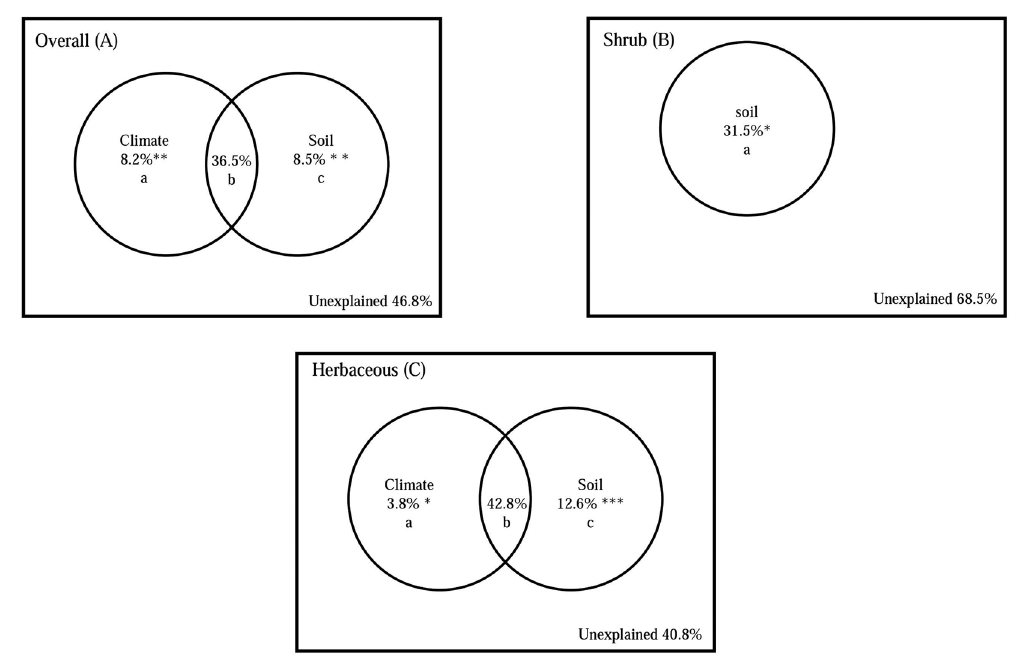
Figure 6. Variation partitioning for the effects of climate and soil attributes on overall ( A ), shrub ( B ), and herbaceous LPSR ( C ). The variation in LPSR in our study was decomposed into the following three fractions: pure effect of climate (a); joint effect of climate and soil attributes (b); pure effect of attributes (c); ** P < 0.01; * P < 0.05; NS, P >